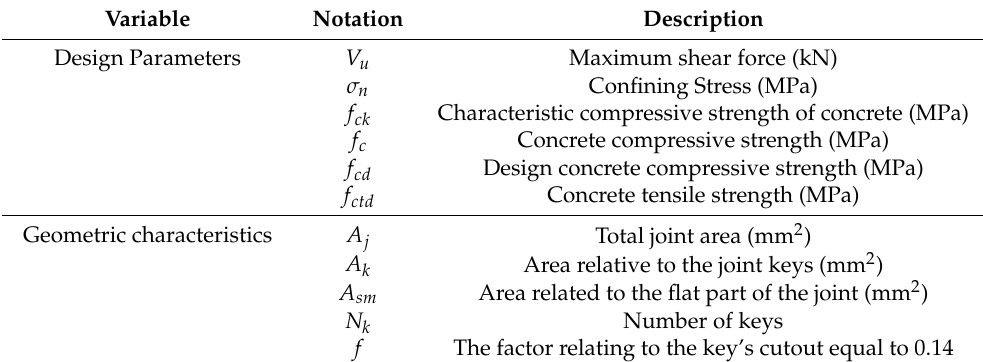
Table 2. Notation used in the equations in Table